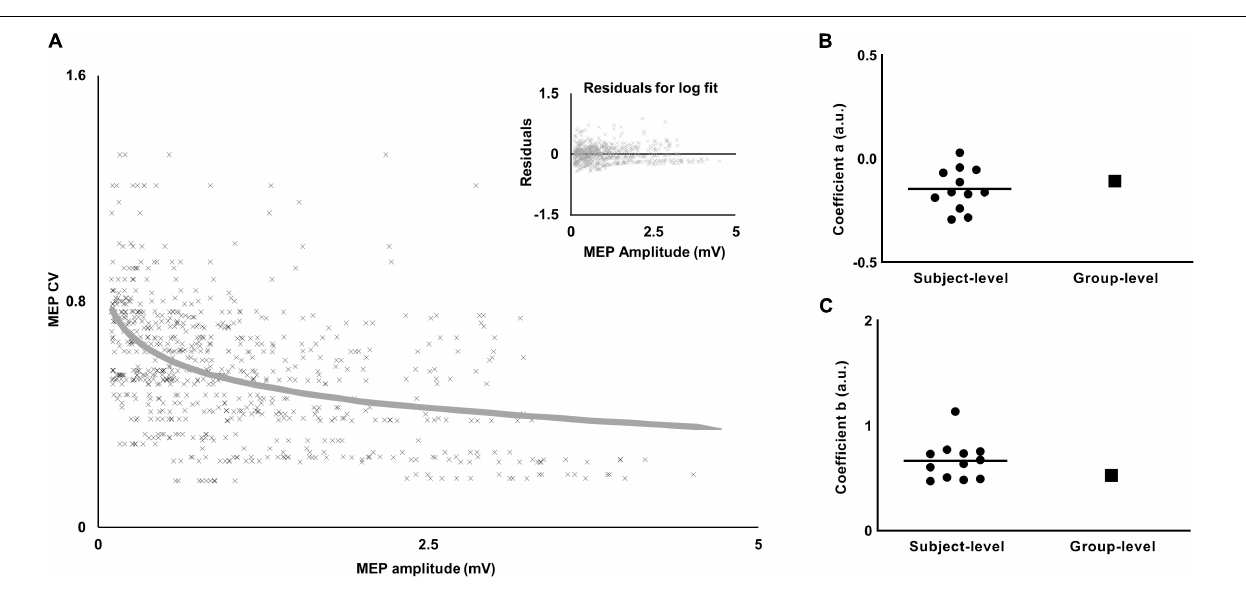
Frontiers in Systems Neuroscience |